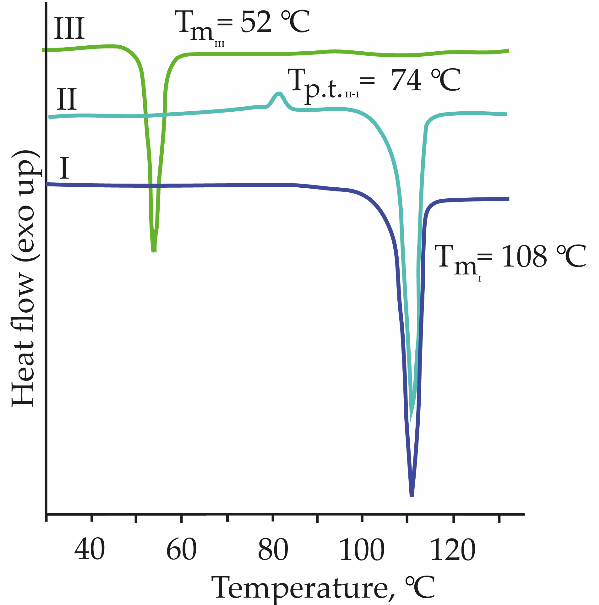
Figure 4. DSC curves of MPBA polymorphs (heating rate 10 °C·min −1 for Forms I and III, 2 °C·min −1 for Form II). The onset temperatures were used to characterize the thermal process occurring in the DSC traces.